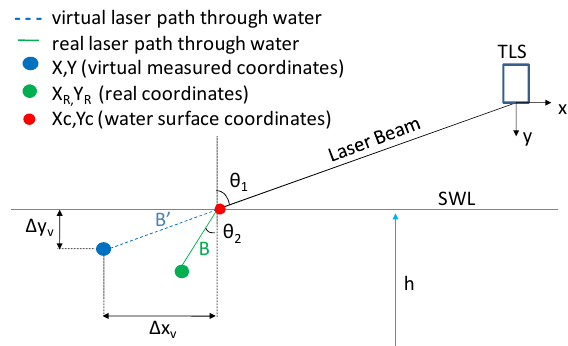
Figure 6. Surface correction after Smith et al.